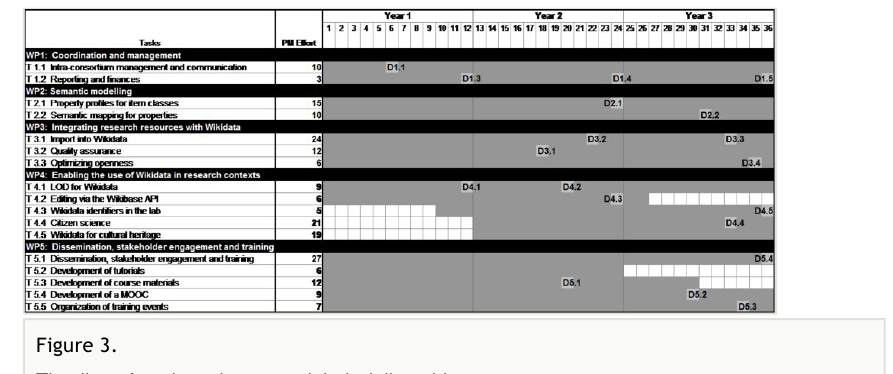
Figure 3. Timeline of work packages and their